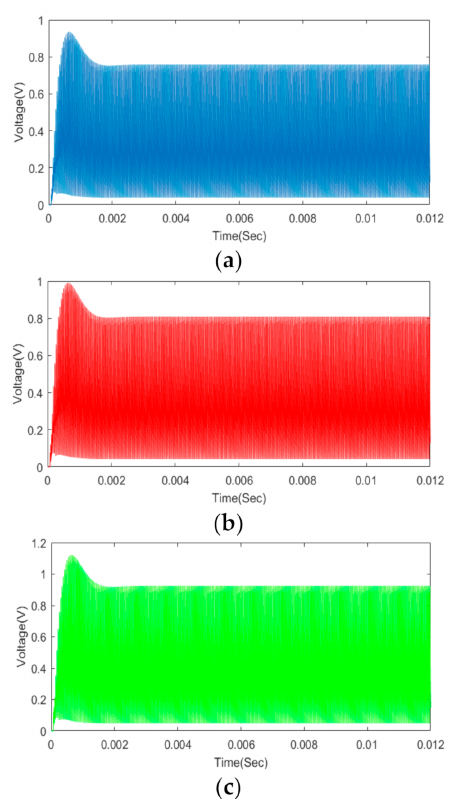
Figure 19. Output voltage of buck converter ( a ) channel 1 ( b ) channel 2 ( c ) channel